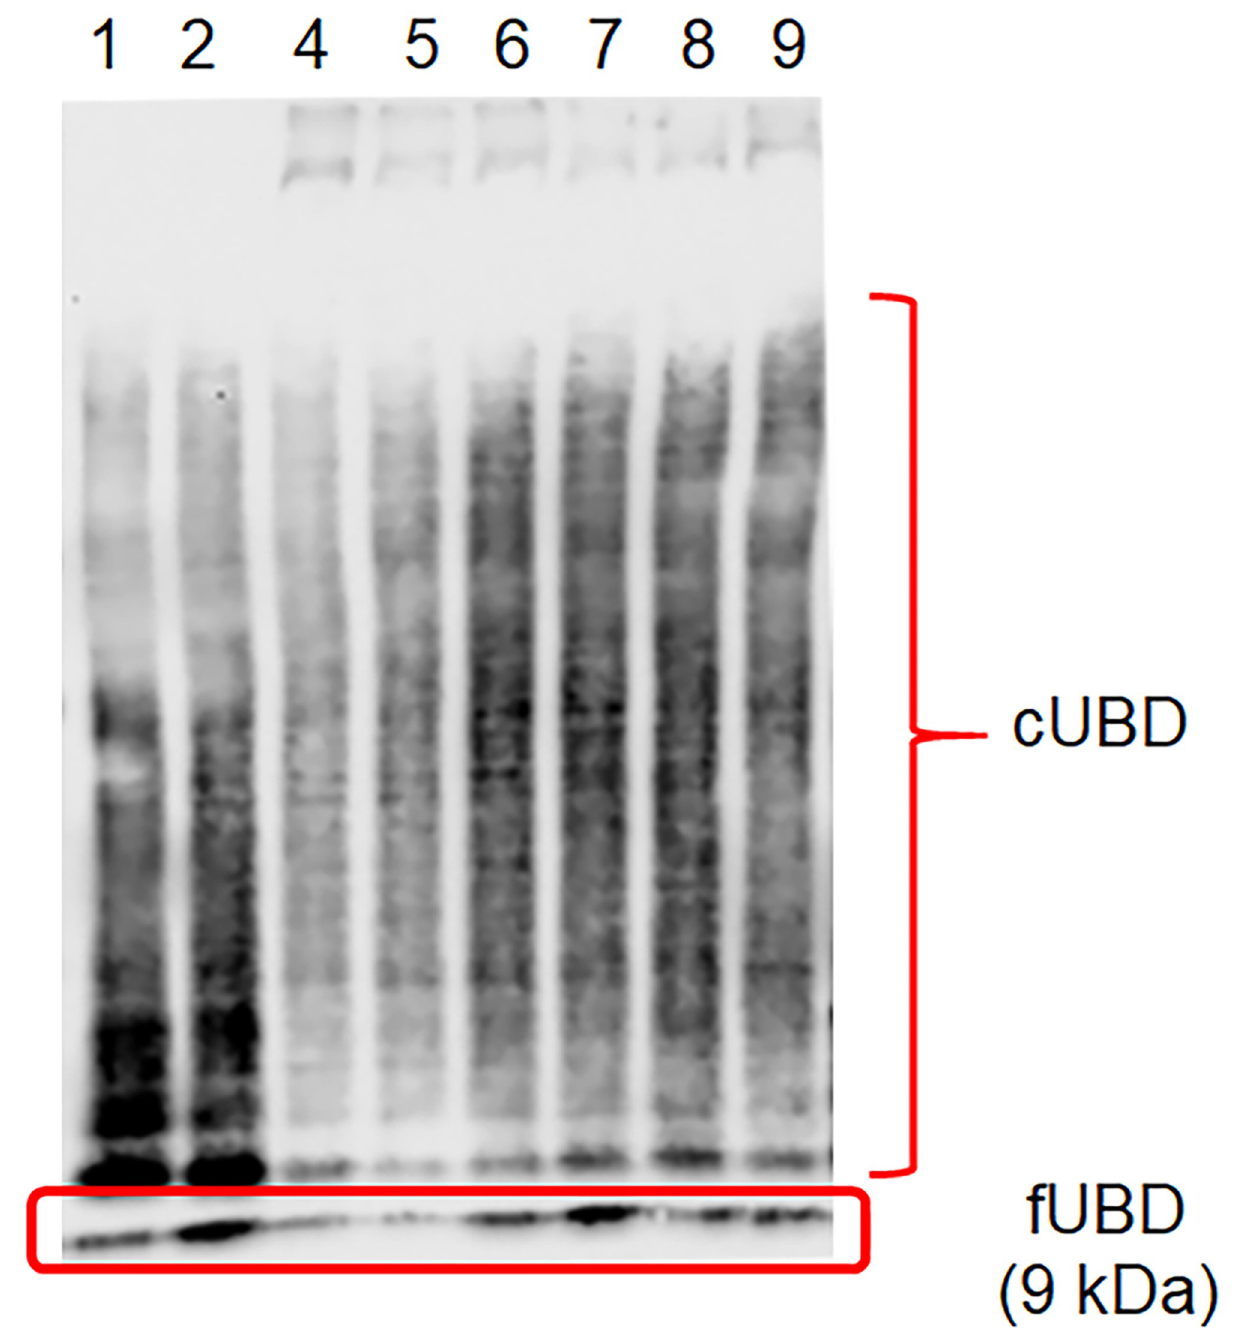
Fig 3. Representative western blots of patients with long-term survival for free ubiquitin D (fUBD) at 9 kDa and conjugated ubiquitin D (cUBD) in saliva. Lane 1, pre-surgery (PreS); lane 2, post-surgery (PostS); lane 3, after treating with chemotherapy drug twice; lane 4, after treating with chemotherapy drug 3 times; lane 5, after treating with chemotherapy drug 4 times; lane 6, after treating with chemotherapy drug 6 times; lane 7, check- up after treating with chemotherapy drug 2 months; lane 8, check-up after treating with chemotherapy drug 4 months.